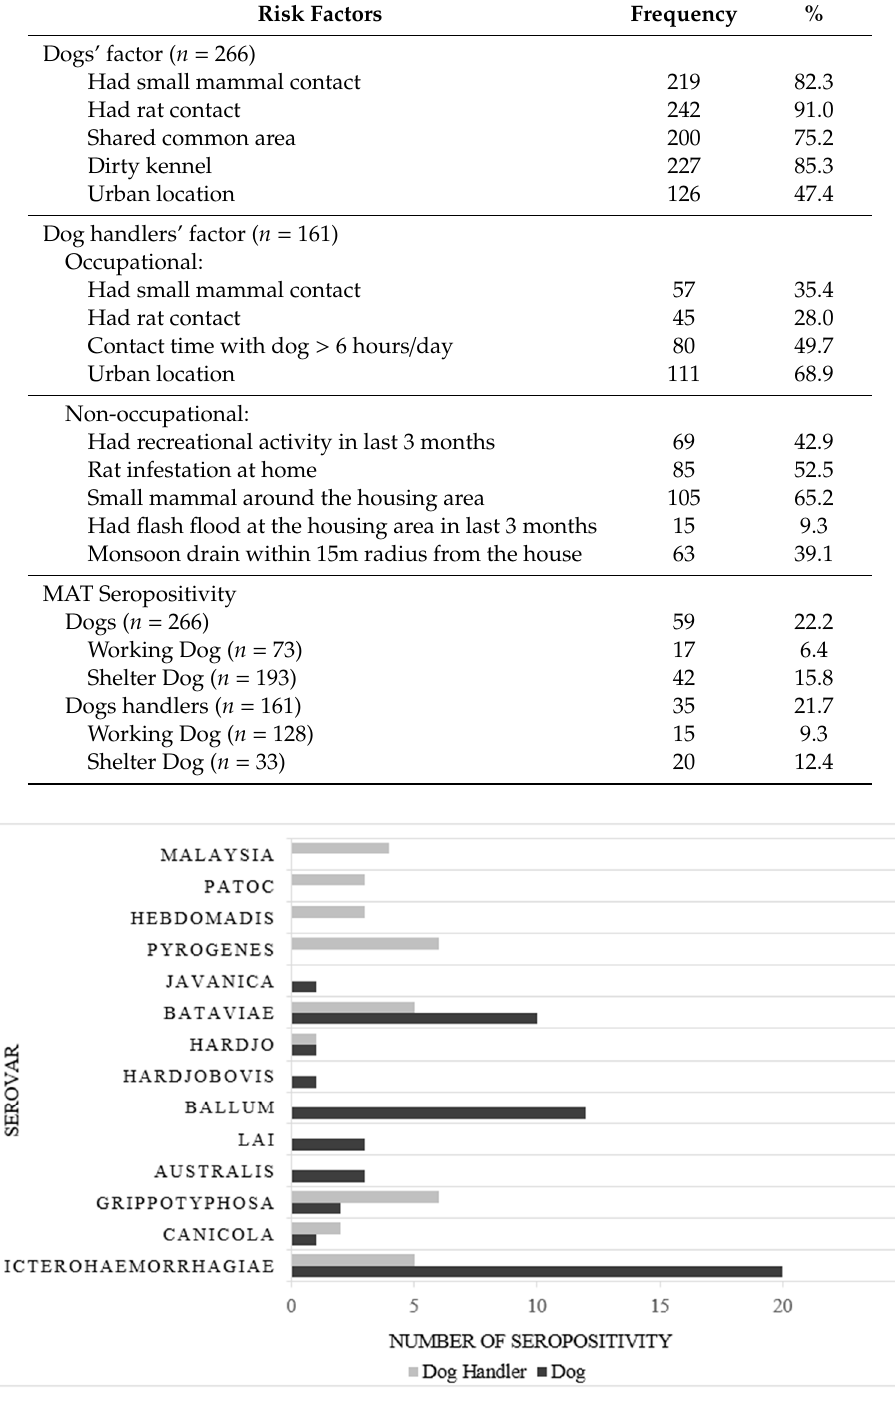
Figure 1. Distribution of leptospiral serovars among dogs ( n = 266) and dog handlers ( n = 161). Table 2. Risk factor affecting dogs’ leptospiral seropositivity from working dog and shelter dog organisations.